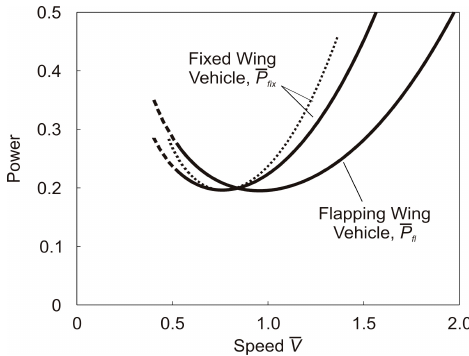
η ). k , 5.0 = η ). k , 5.0 = prop flap prop flap